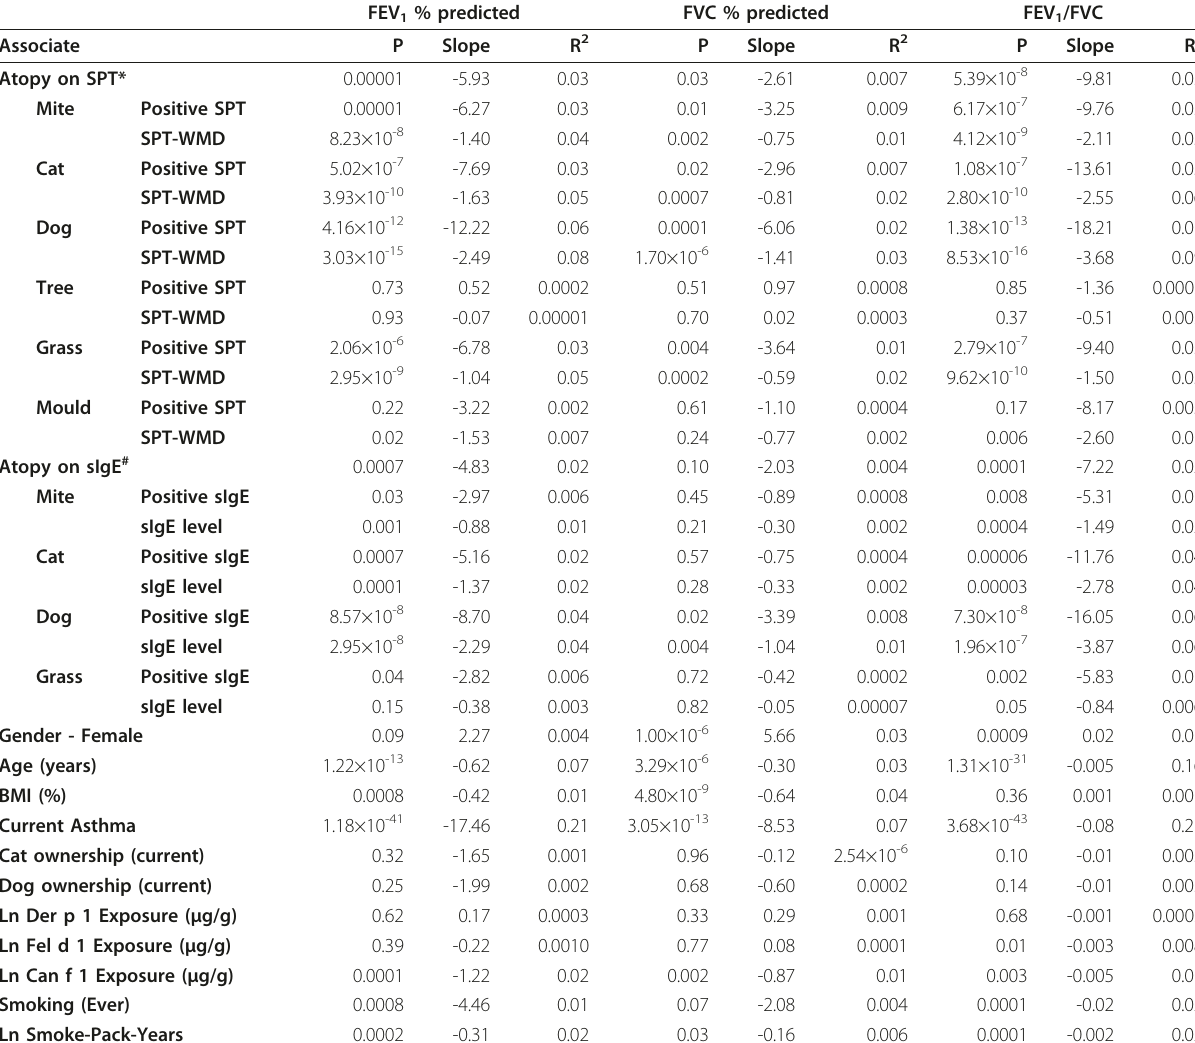
Table 4 Associates of FEV 1 and FVC % predicted and FEV 1 /FVC (univariate